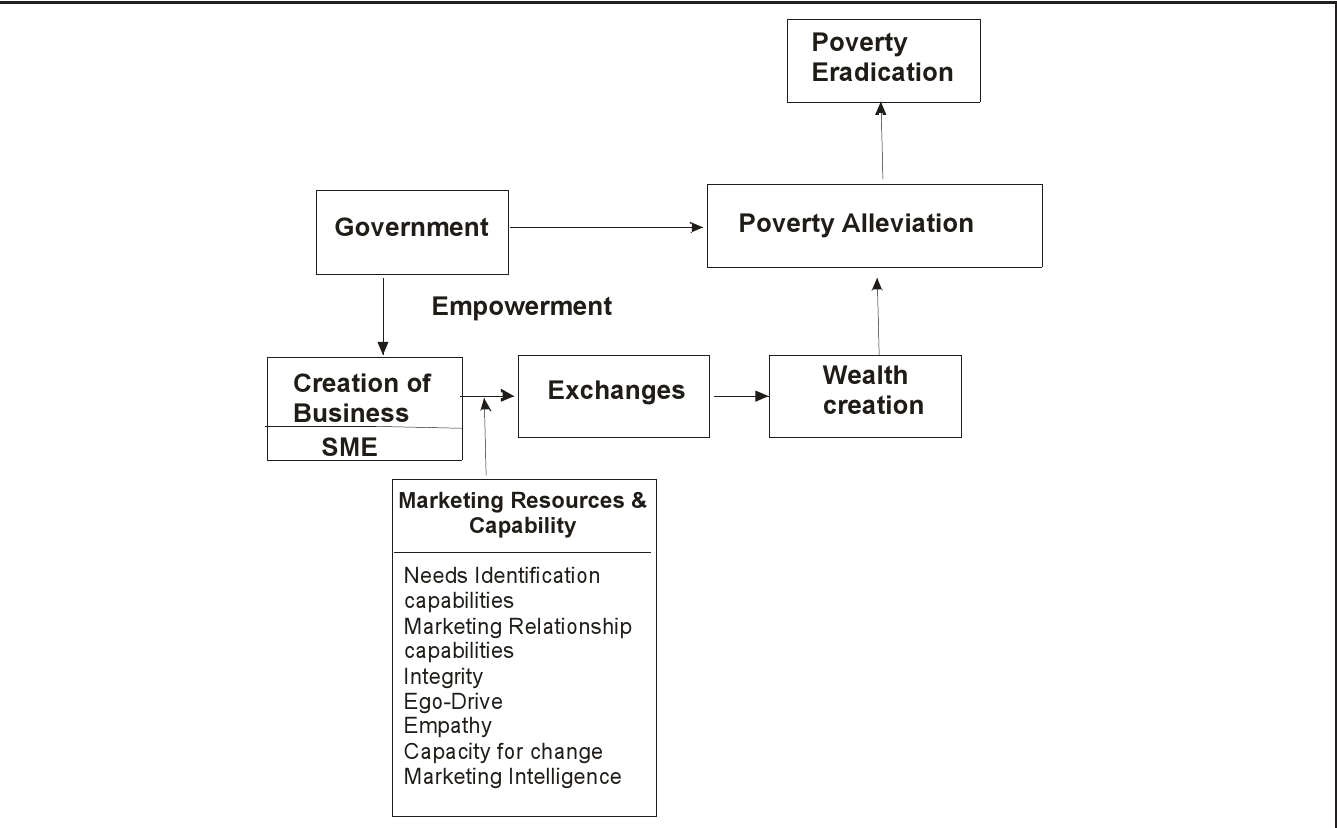
Figure 1. A conceptual model of marketing mediation of SMEs–poverty alleviation